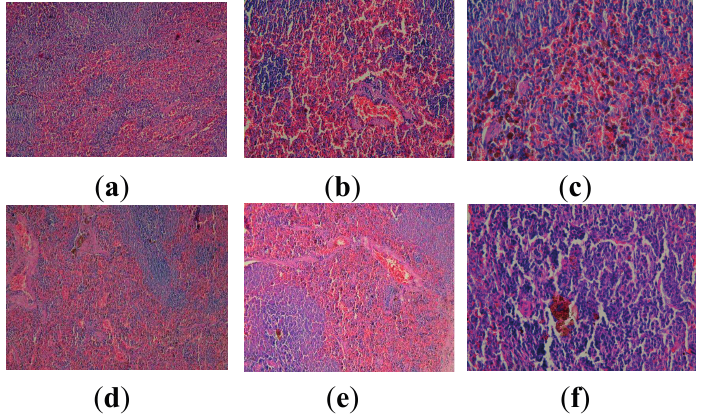
Figure 5. Histopathological evaluation of splenic tissue for the experimental